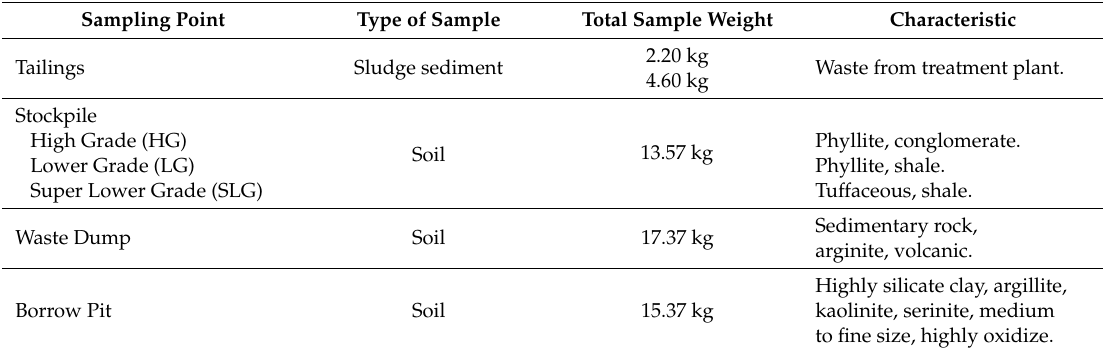
Table 1. Descriptions of the sampling points at Selinsing Gold